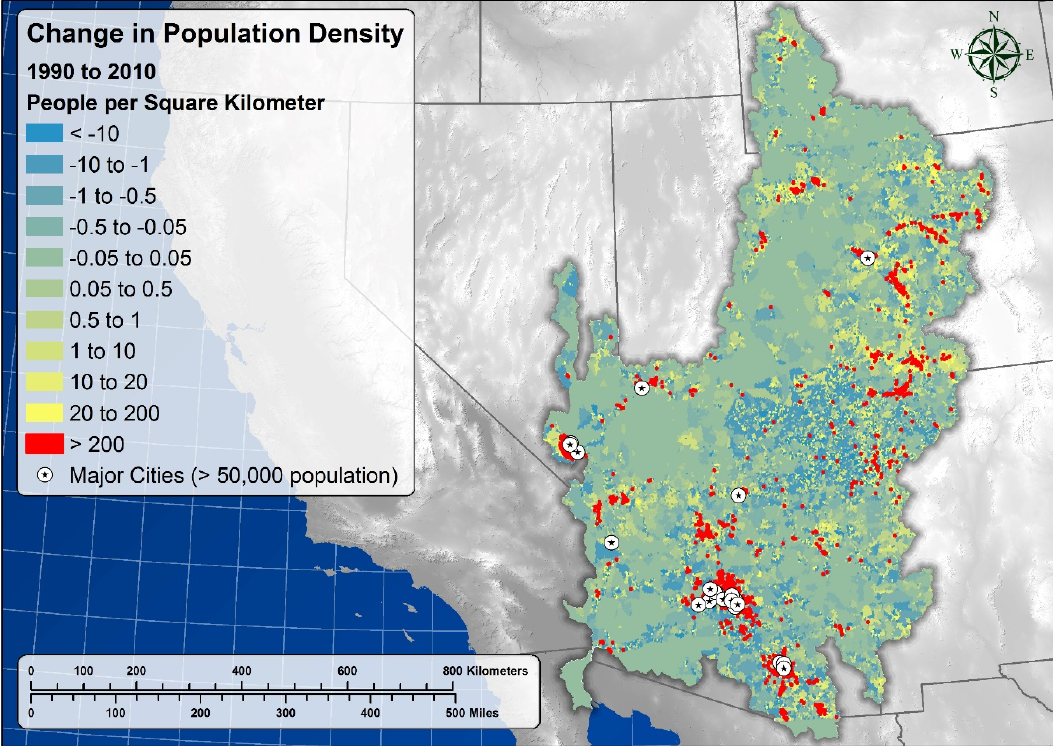
Figure 5. Human population density (residents/km 2 ) from 1990 to 2010 in the Colorado River Basin.